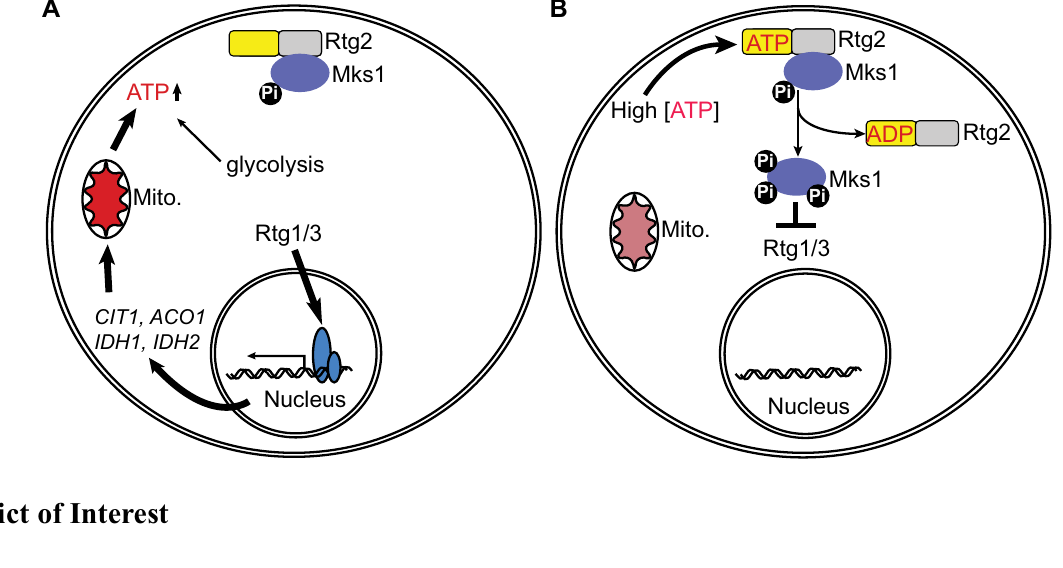
Figure 6. A model for the role of ATP-mediated interaction between Rtg2 and Mks1 in ATP homeostasis. See text for